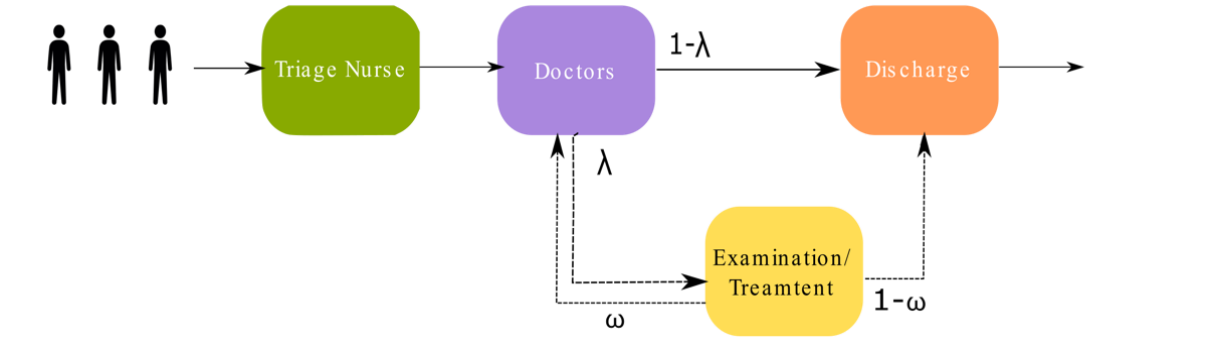
Figure 1. Illustration of the urgent care center, where patients arrive without any planned appointment. In the first step, a triage nurse runs a symptom assessment, and then patients are directed to the doctor. Depending on their situation, they may be examined/treated by another nurse and then discharged, sent back to a doctor, or discharged immediately by administrative staff.